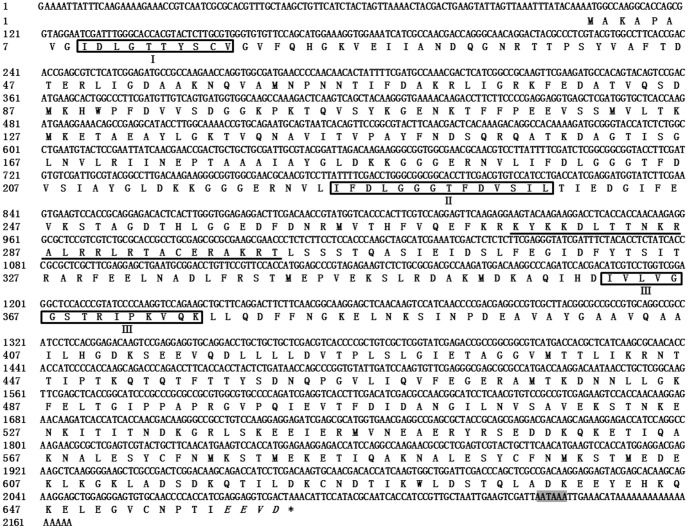
Nucleotide and deduced amino acid sequences of Lg-hsc70.The upper sequences indicate the nucleotides, and the lower sequences show the inferred amino acids. The start and stop codons are in bold. The signature sequences of the HSP70s family are shown in boxes, the nuclear localization signal sequence is underlined, the consensus sequence EEVD at the C-terminus is indicated in italics and the consensus polyadenylation signal (AATAAA) is shown in a gray box.